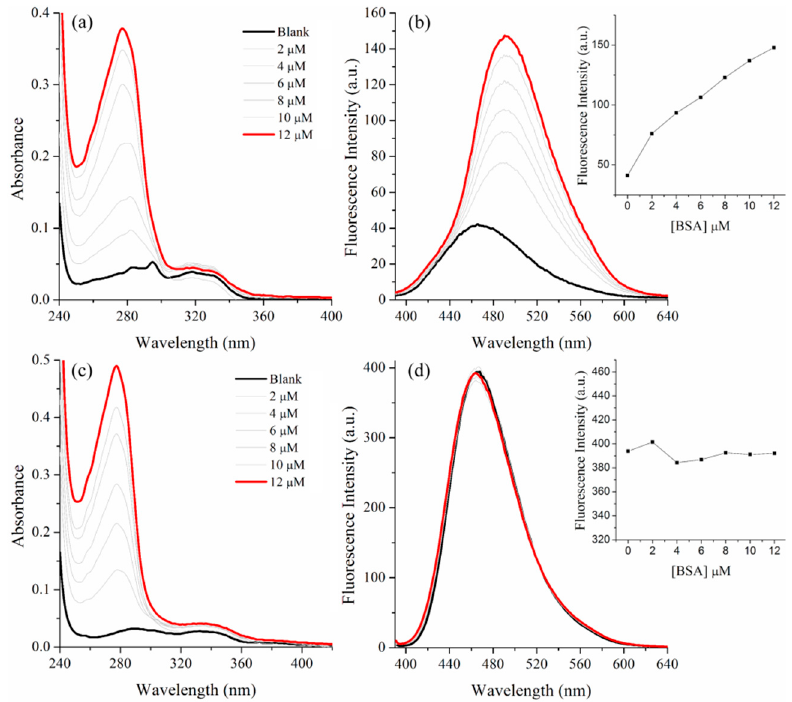
Figure 6 . UV-Vis and fluorescence emission spectra of the benzazoles (2 μ M) 12 (a and b) and 15 (c Figure 6. UV-Vis and fluorescence emission spectra of the benzazoles (2 µ M) 12 ( a , b ) and 15 ( c , d ) and d) in different BSA concentrations (0–12 μ M). The insert presents the respective plot of fluo- in different BSA concentrations (0–12 µ M). The insert presents the respective plot of fluorescence rescence intensity maxima as a function of BSA concentration. intensity maxima as a function of BSA